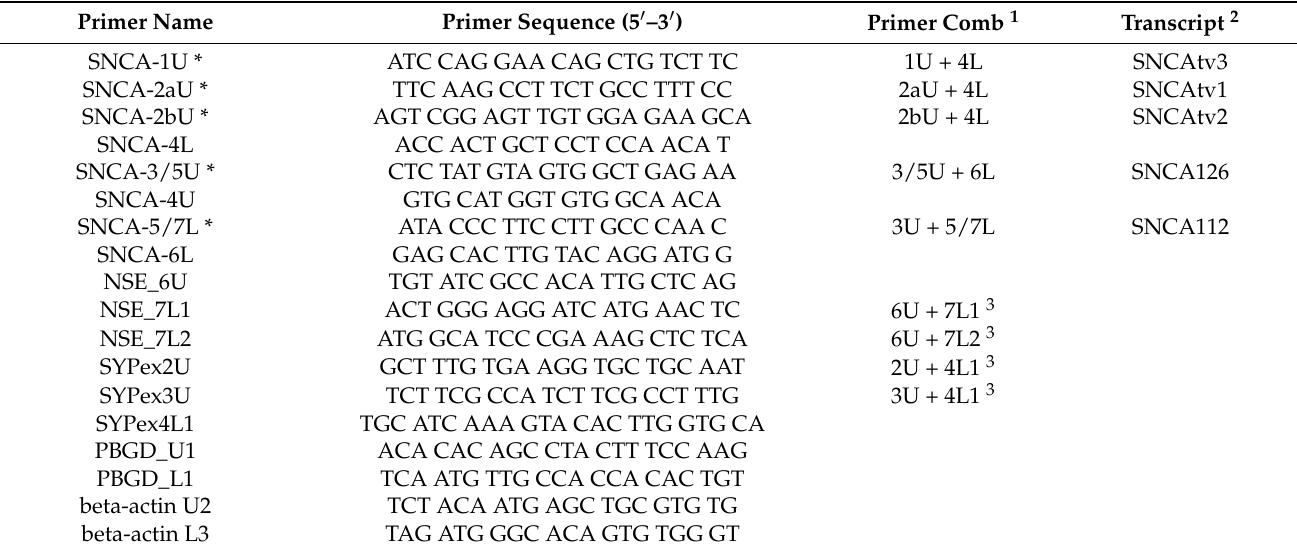
Table 6. cDNA primer sequences used for PCR amplification of SNCA transcript variants, neuron-specific enolase, synaptophysin, beta-actin and porphobilinogen